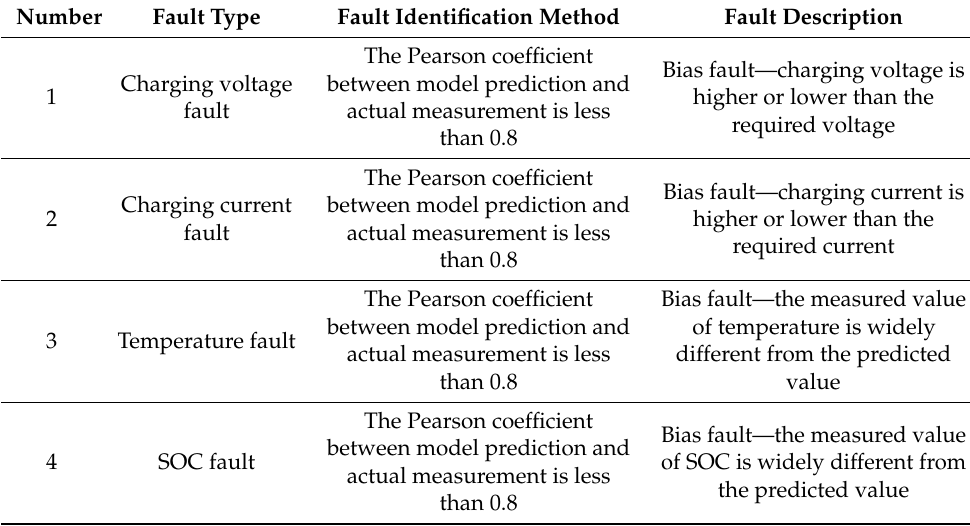
Table 2. Fault types and identification methods